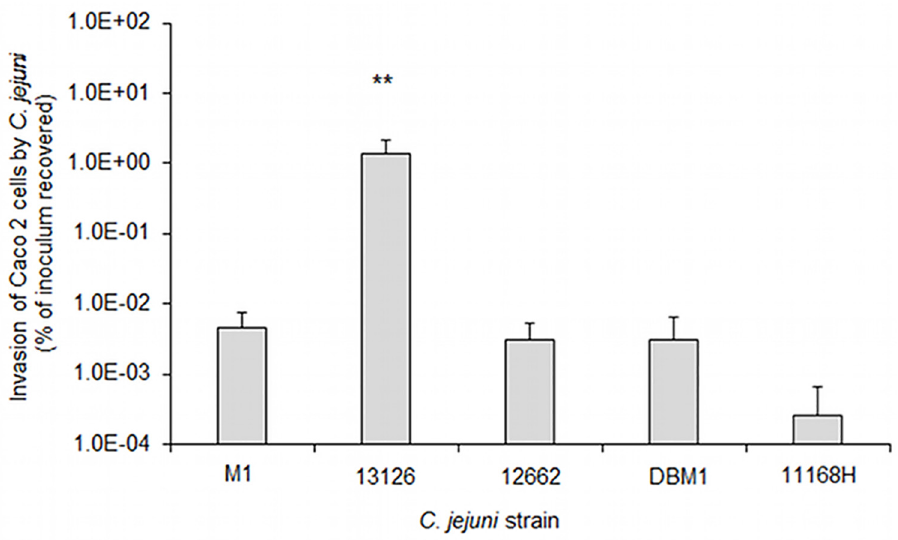
Fig 3. C . jejuni 13126 displays enhanced invasiveness in Caco-2 cells. Invasion of Caco 2 cells by five C . jejuni strains was examined. Asterisks show statistically significant differences in invasion levels between C . jejuni 13126 and the other four strains as assessed by one-way ANOVA ( ** p = 0.01).